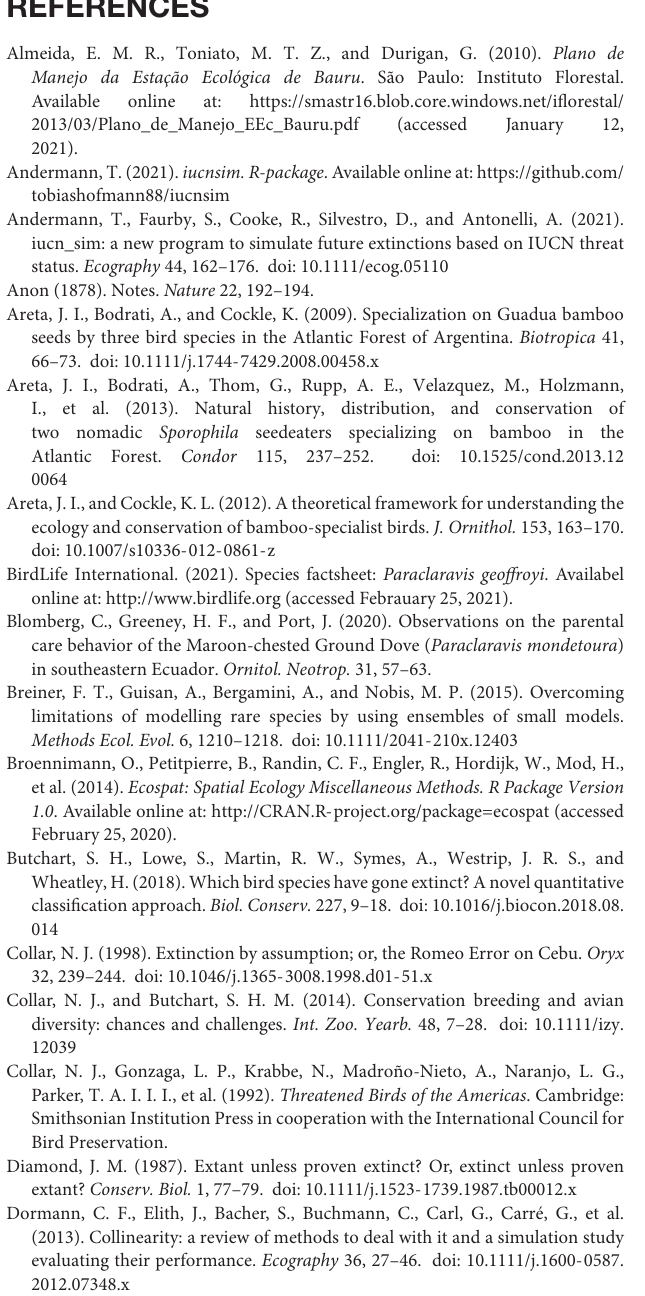
Supplementary Figure 1 | Representative sonograms of the vocalizations of Purple-winged Ground Dove Paraclaravis geoffroyi , Maroon-chested Ground Dove Paraclaravis mondetoura , and Violaceous Quail-Dove Geotrygon violacea including accession numbers for recordings in Macaulay Library and xeno-canto. Supplementary Table 1 | Records of Purple-winged Ground Dove Paraclaravis geoffroyi used in this study and associated metadata. Supplementary Table 2 | Input data for specimen and sighting records to calculate the extinction probability of Purple-winged Ground Dove Paraclaravis geoffroyi using the method provided by Thompson et al. (2017).